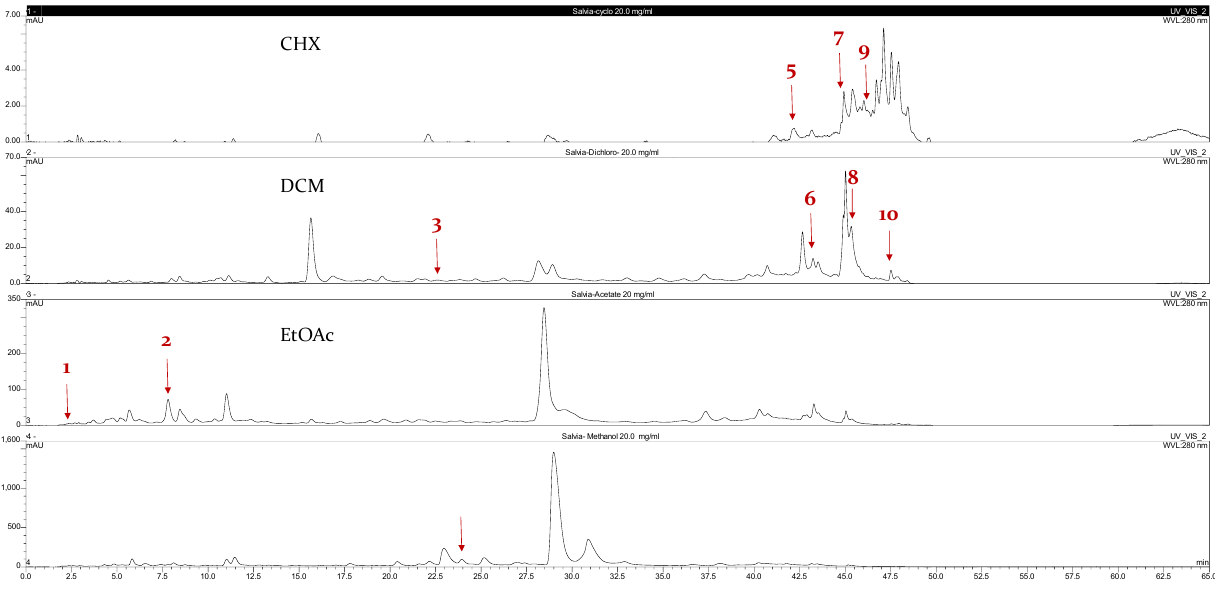
Figure 3. HPLC chromatograms of the four extracts of S. fruticosa: CHX, DCM, EtOAc and MeOH extracts. 3-amino-4-hydroxybenzoic acid ( 1 ); 3,4-dihydroxy-5-methoxybenzoic acid ( 2 ); rutin ( 3 ); polydatin ( 4 ); 5′ , 3′ -dihydroxyflavone ( 5 ); 5,7-dihydroxy-4-phenylcoumarine ( 6 ); 3-benzyloxy-4,5-dihydroxy-benzoic acid methyl ester ( 7 ); 4′ ,5-dihydroxy-7-methoxyflavone ( 8 ); pinosylvin monomethyl ether ( 9 ); 3,6, 3′ - trimethoxyflavone ( 10 ).